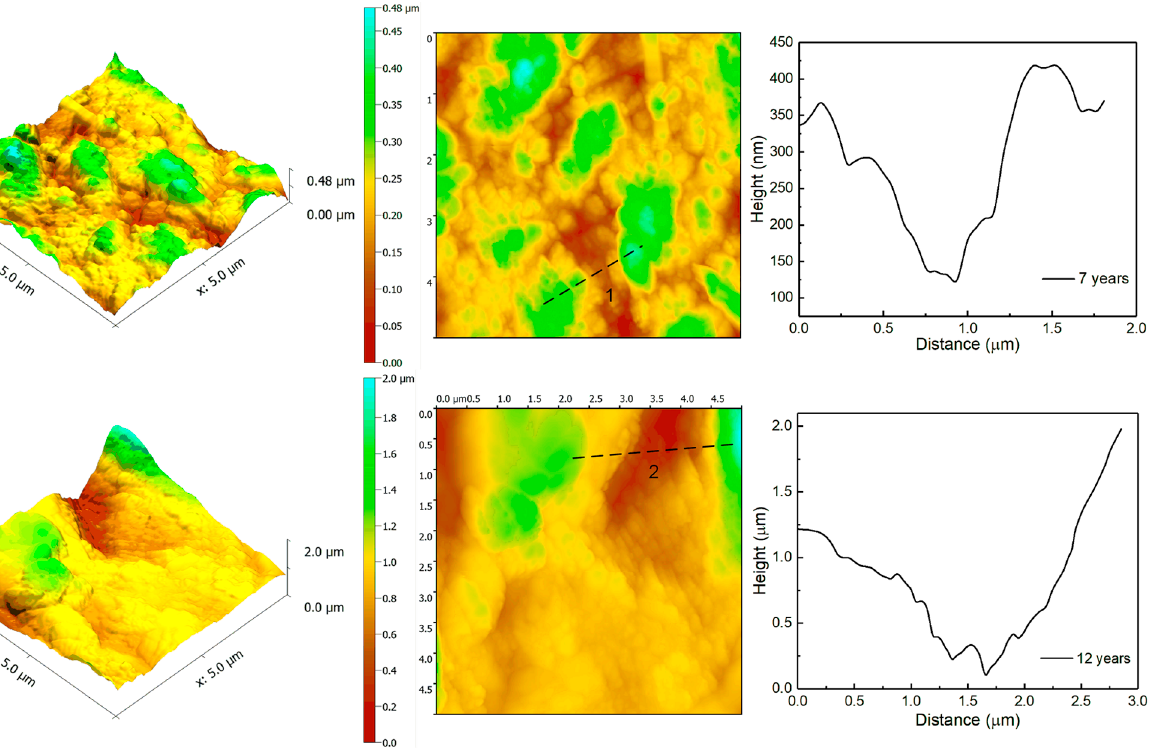
Figure 12. 3D AFM morphologies, 2D AFM morphologies and height profiles of epoxy primer-coated aluminum alloys exposed for different numbers of years: ( a ) 7 years; ( b ) 12 years; ( c ) 20 years. 3.2. Sectional Characterization Figure 13 shows the cross-sectional morphology and energy spectra of the epoxy pri- mer-coated aluminum alloy exposed for different numbers of years. It is clear from Figure 13a that after seven years of exposure, the epoxy coating was bonded well to the anodic oxidation film, and no cracking had occurred. As shown in Figure 13b, many significant defects appeared on cross-sections of the epoxy coating after exposure for 12 years. After exposure for 20 years, transport channels for corrosive ions were formed by cracks on the epoxy coating, which corroded the anodic oxidation film and caused the intergranular corrosion (IGC) of the aluminum substrate. The area where the epoxy coatings on the specimen had peeled after exposure for 20 years was analyzed, as shown in Figure 13d. Severe intergranular corrosion appeared on the aluminum substrate and exfoliated corro- sion appeared on its intermediate layer. By analyzing the composition of the products of corrosion at point A, we noted that the amounts of Al and O were high. This might have occurred because the substrate was in a state of passivation after local pitting, and the precipitated phase (Al − Cu − Fe − Mn − Si), with a higher electrochemical potential relative to